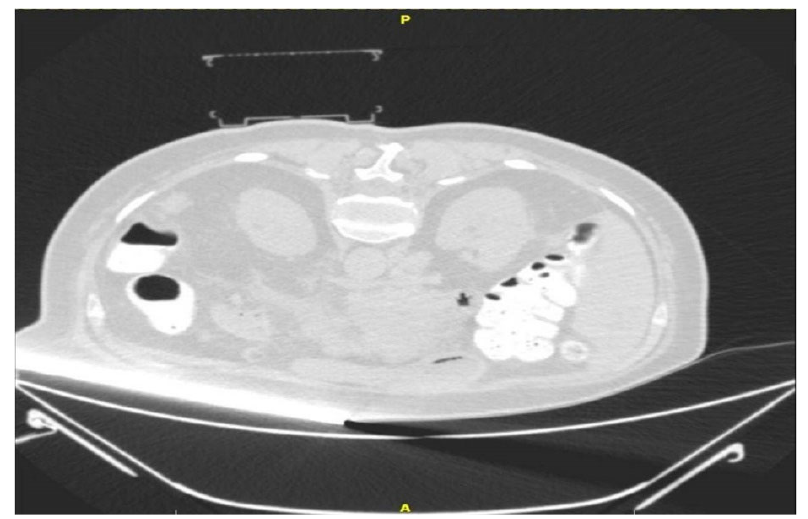
Figure 2. Initial CT scan with target and the cube mounted on the skin.